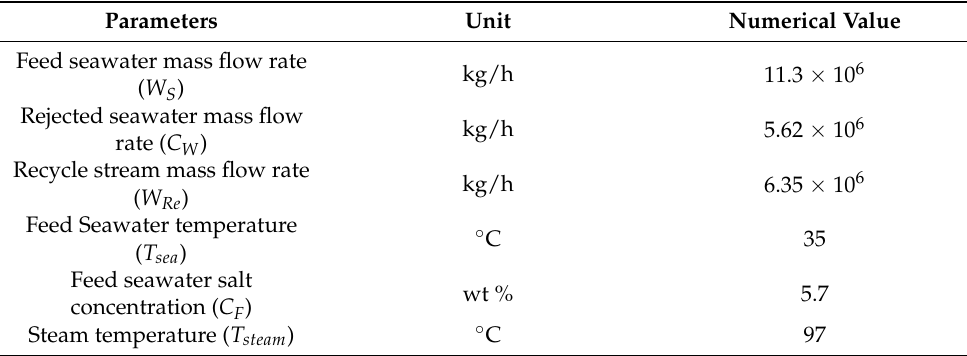
Table 3. Dynamic simulation operation parameters of the MSF system.